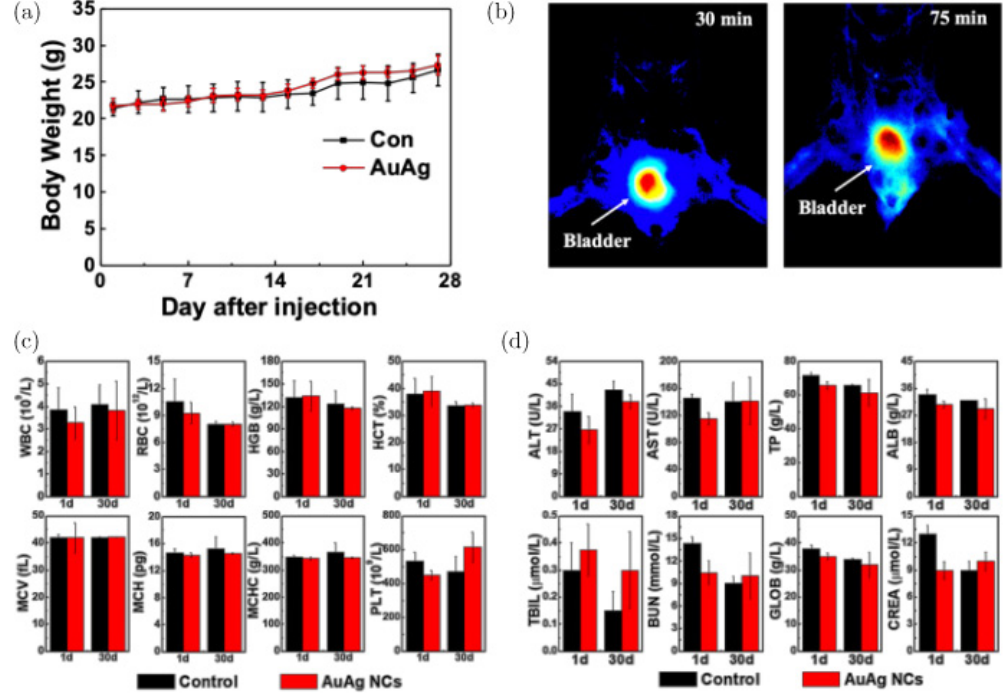
Fig. 6. In vivo toxicity detections, including (a) changing trend of mice's weight in the following 4 weeks after injection, (b) biodistribution of 30 min p.i. and 75 min p.i. by in vivo °uorescence imaging and (c – d) Mice's hematology data and blood chemistry which were acquired at 2 time points (1 d/30 d). Mice were treated with 0.2 mL (2 mg/mL) AuAg NCs via administered intra- peritoneal injection once at ¯rst day. Data were counted by Student's t